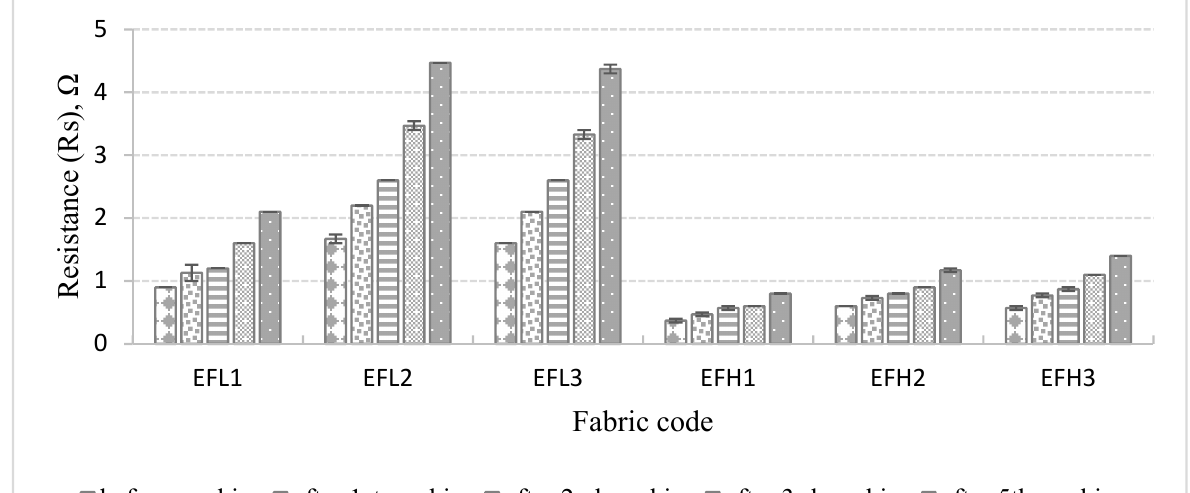
Figure 11. Resistance of EFL1, EFL2, EFL3, EFH1, EFH2, and EFH3 structured electro-conductive fabrics before and after different numbers of washing and drying cycles.